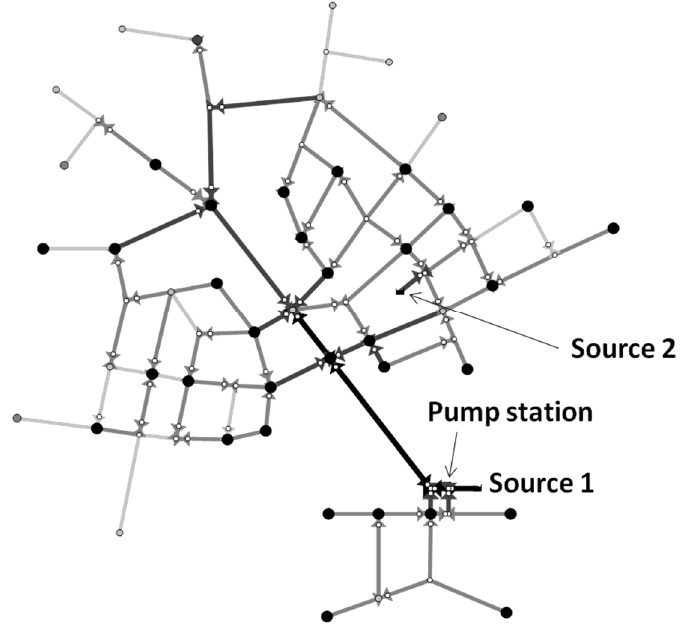
Figure 6. Study network layout. A thicker pipe represents a larger diameter, while a larger node represents a larger demand.